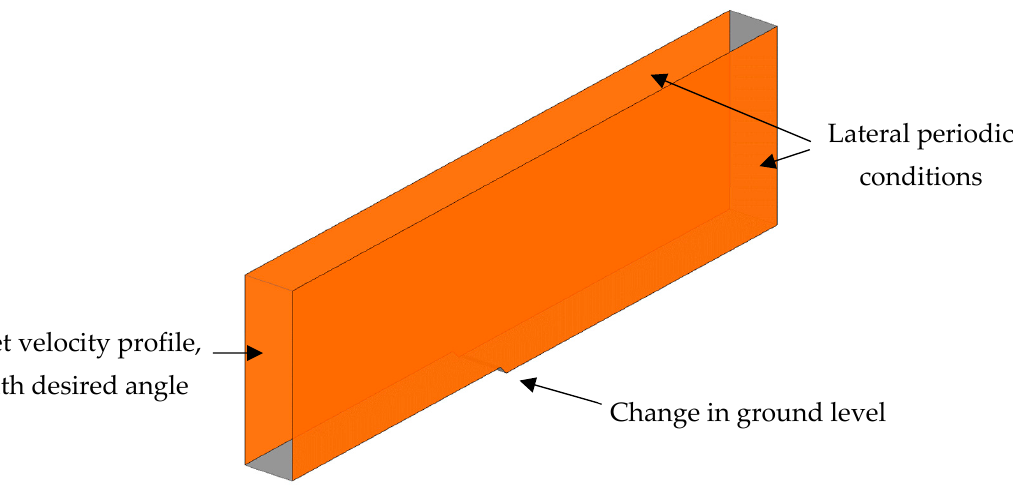
Figure 15. Preliminary CFD model for determining the inlet velocity profile of the real topology